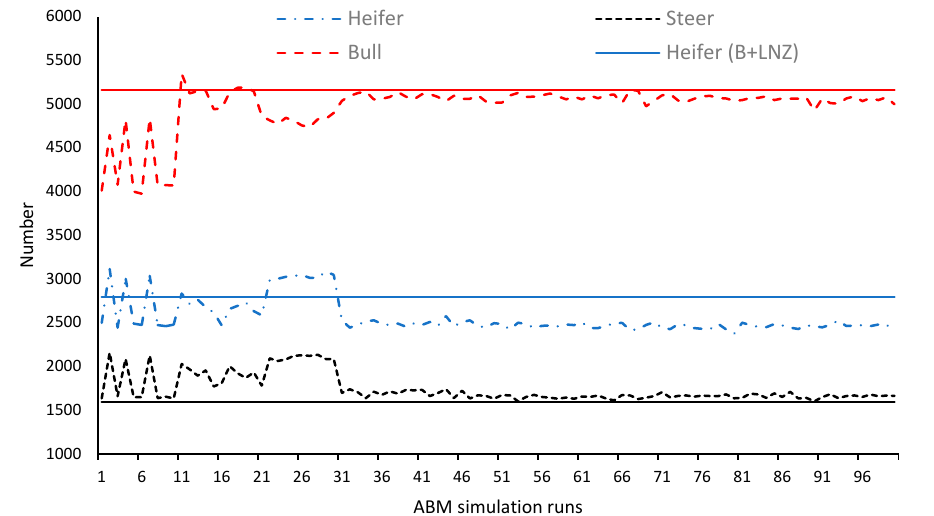
Figure 1. The total number of traditional dairy-origin heifer (blue dash dotted line), steer (black dotted line), and bull (red dashed line) processed in the ABM across each of the 100 runs. The solid lines in each class of beef cattle represented the actual Beef and Lamb New Zealand (B + LNZ) average values.